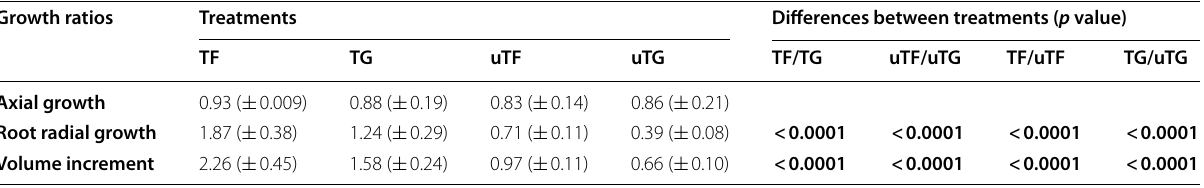
The ratio of axial growth is the axial growth 4 years after treatment related to the axial growth 4 years prior to treatment. The ratio of root ring width is the root ring width 4 years after treatment related to the root ring width 4 years prior to treatment. The ratio of volume increment is the volume increment in the stem below the guy-wiring point 4 years after treatment related to the volume increment in the stem below the guy-wiring point 4 years prior to treatment. Ratios are dimensionless; a ratio of 1 means growth was unchanged. TF Thinned trees free to sway, TG Thinned and guy-wired trees, uTF Unthinned trees free to sway, uTG Unthinned and guy- wired trees. P values refer to Tukey test results